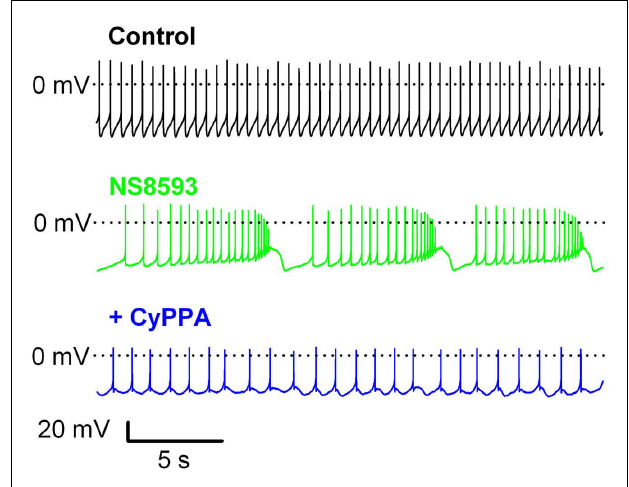
FIGURE 4 | CyPPA reverses the effect of the negative SK channel modulator, NS8593, on the spontaneous activity of rat SNc neurons in midbrain slices. Pacemaker-like AP firing recorded under control conditions (upper panel) is changed into bursting upon application of 10 μ M NS8593 (middle panel). Note the progressive decrease in spike amplitude during the plateau phase and the sudden hyperpolarizations separating the bursts. Co-application of CyPPA (10 μ M) decreases the number of spikes, reduces the duration of the plateau and increases the precision of action potential firing.